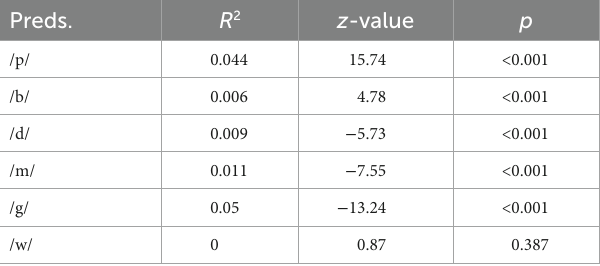
TABLE 4 Results of the generalized linear mixed-effects model applied to all samples testing the effect of phoneme count on base friendship. Preds. R 2